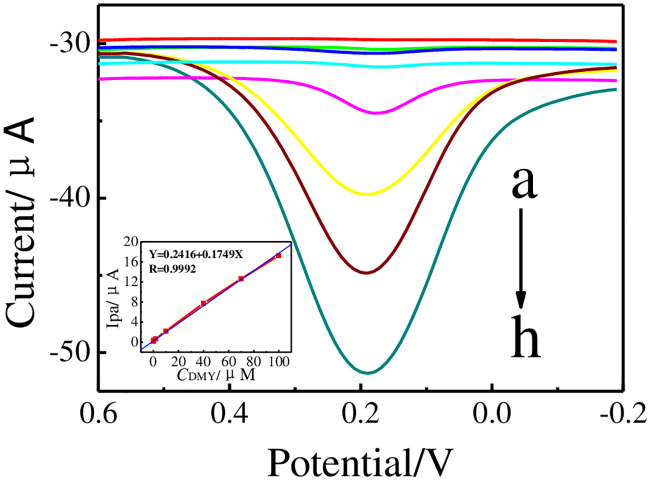
DPVs of GCE│rGO-Au/MIPs in PB containing 0 (a), 0.02 (b), 0.2 (c), 2.0 (d), 10.0 (e), 40.0 (f), 70.0 (g), and 100.0 (h) μM of DMY.Insets: the calibration curve of CDMY
vs. Ipa.